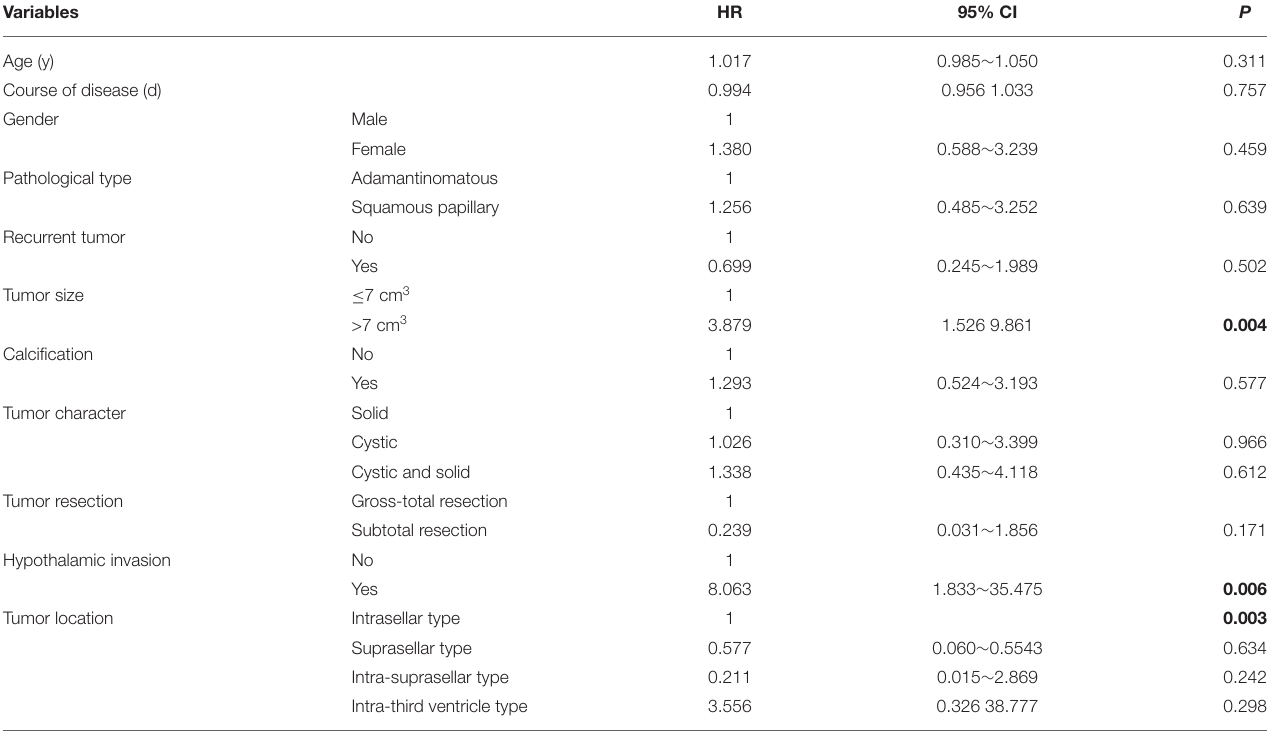
TABLE 4 | Factors associated with psychiatric disorders—Univariate analysis.